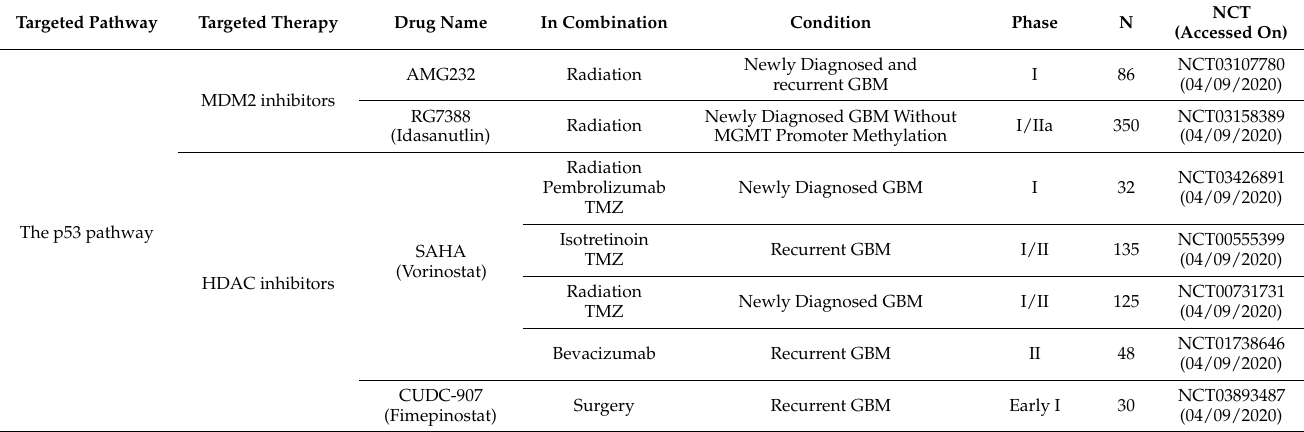
Table 2. Current on-going clinical trials of targeted therapies in GBM within the last 5